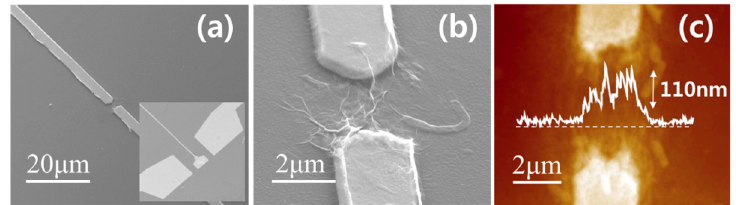
Figure 2. SEM image of ( a ) biosensor device with GSG pattern, (inset) signal line, and ( b ) PBA/reduced graphene oxide (RGO) interconnector part ( c ) AFM image of PBA/RGO interconnector.